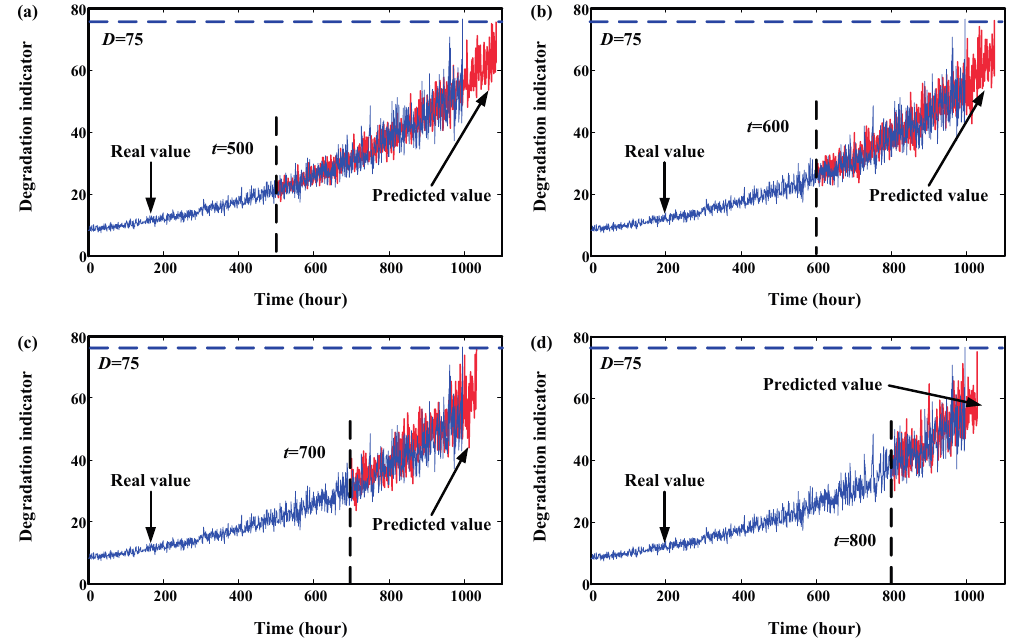
Figure 11. Trend prediction results of simulated data of Component 1. ( a ) prediction results at start time 500 h; ( b ) prediction results at start time 600 h; ( c ) prediction results at start time 700 h; ( d ) prediction results at start time 800